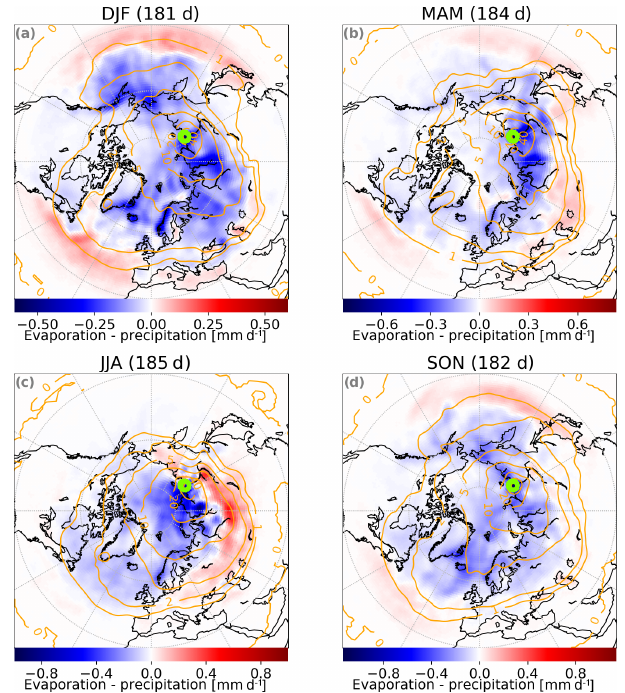
Figure 7. Same as Fig. 6, with colours indicating the seasonal av- erages of evaporation minus precipitation (mmd − 1 ): red (blue) in- dicates regions where evaporation is stronger (weaker) than precip-